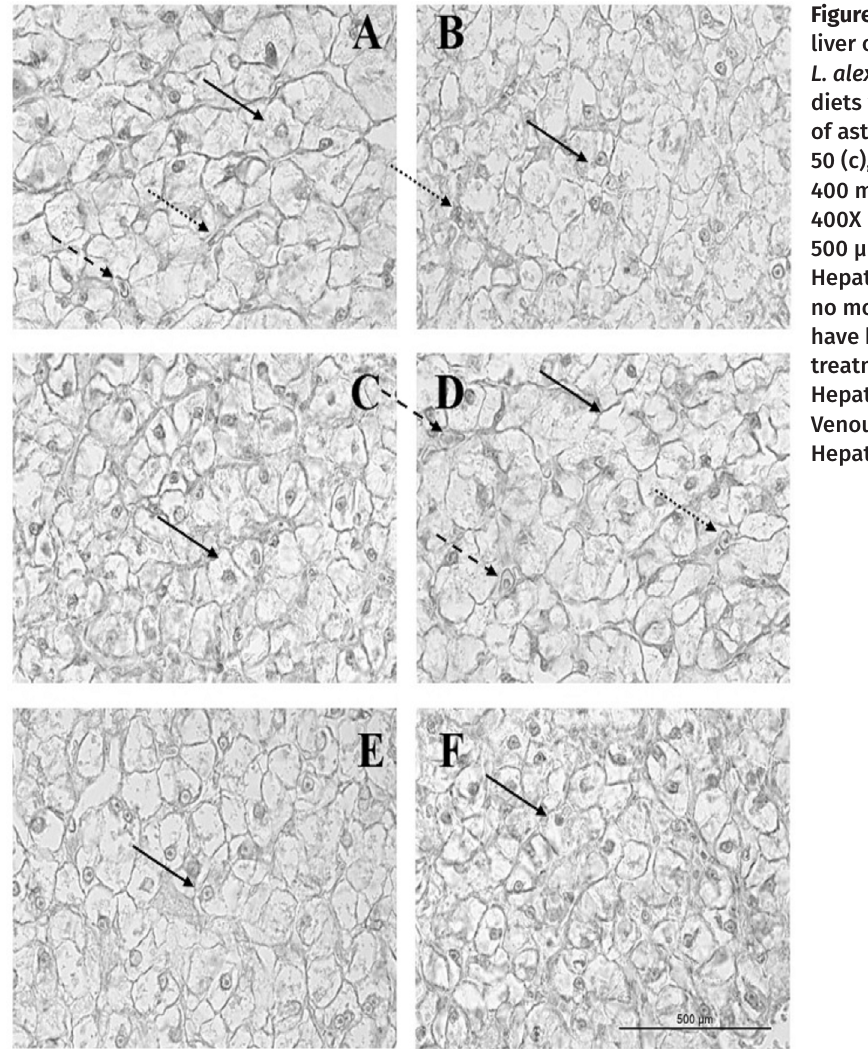
Figure 5. Photomicrograph